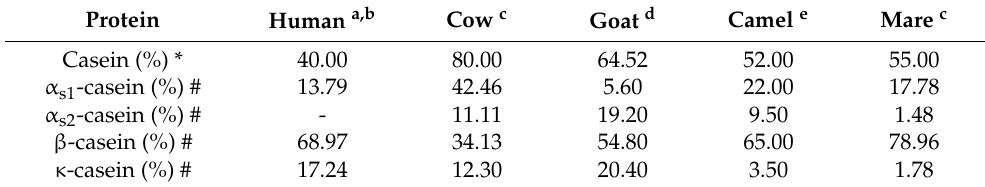
Table 1. The proportions of casein, α S1 -casein ( α S1 -CN), α S2 -casein ( α S2 -CN), β -casein ( β -CN),